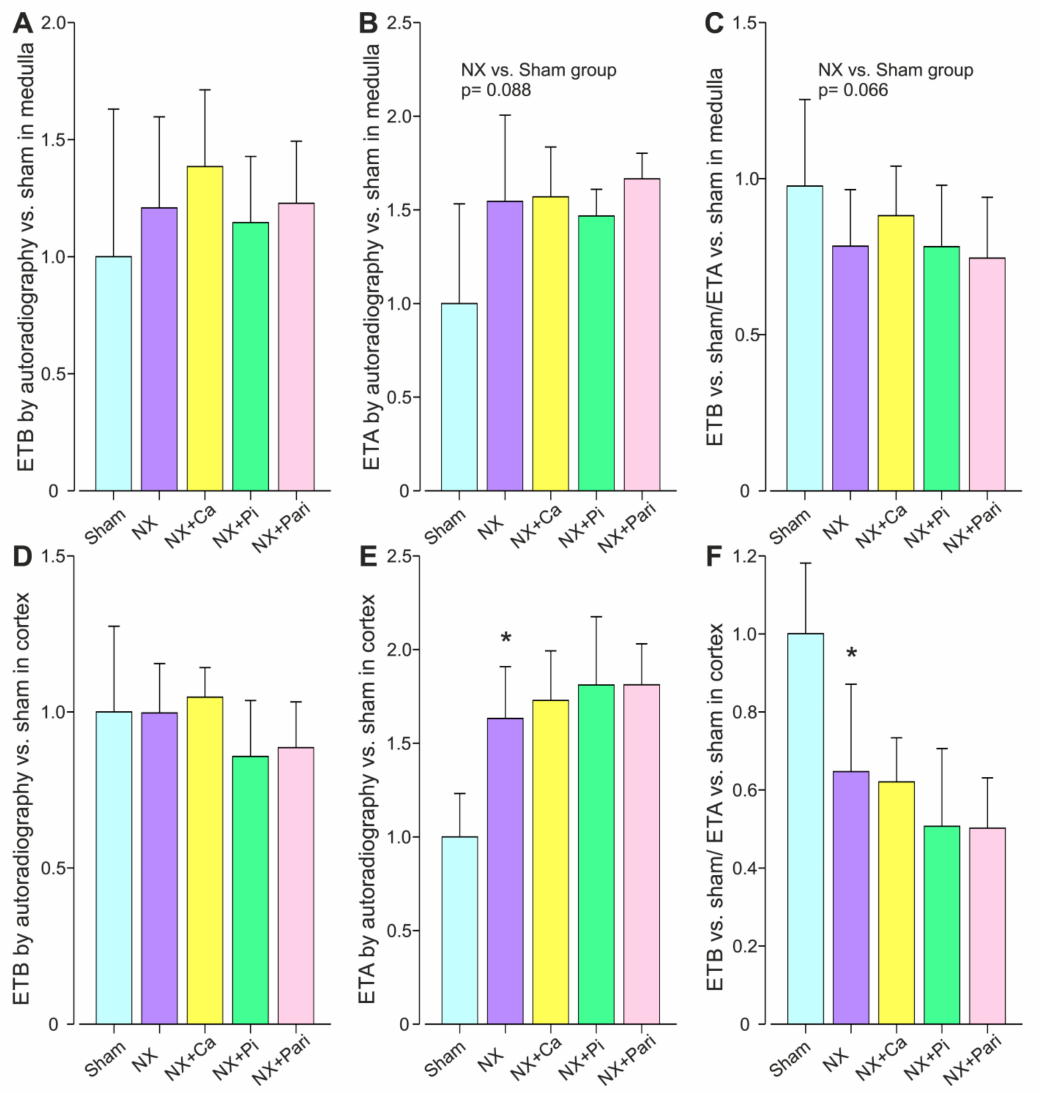
Figure 3. Kidney medullary ETB ( A ) and ETA ( B ) receptor protein content, and the ETB:ETA protein ratio ( C ); and kidney cortical ETB ( D ) and ETA ( E ) receptor protein content, and the ETB:ETA receptor protein ratio ( F ) quantified using autoradiography in the twenty-seven-week 5 / 6 nephrectomy model; NX, 5 / 6 nephrectomy; Sham, sham-operation; Ca, 3.0% calcium diet; Pi, 1.5% phosphate diet; Pari, 100 ng / rat of intraperitoneal paricalcitol three times weekly; n = 7 − 13 / group. Values are mean ± 95% confidence interval of the mean. * p < 0.05 vs.